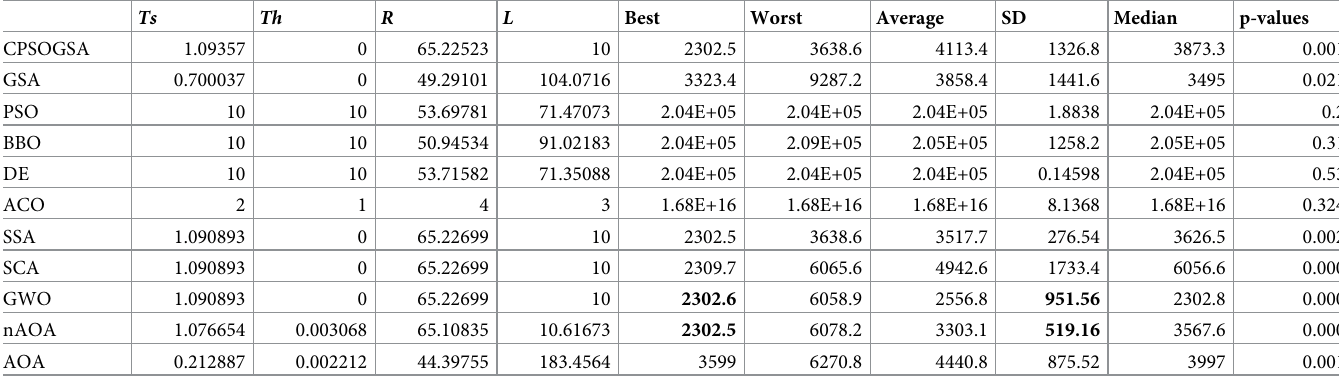
Table 8. Results for experiment conducted for